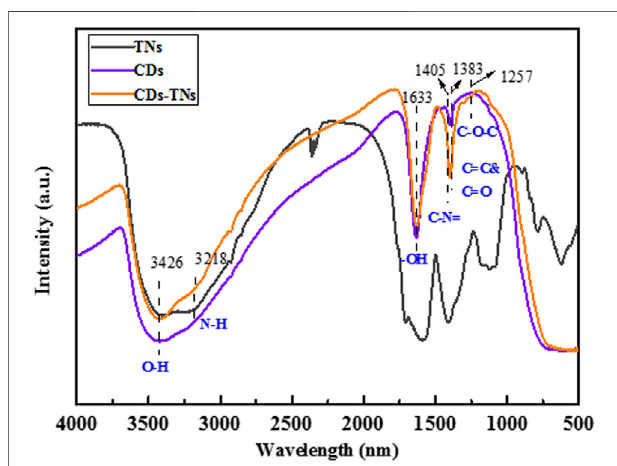
FIGURE 6 | FTIR spectra of CDs, TNs, and 0.2CD-TNs.